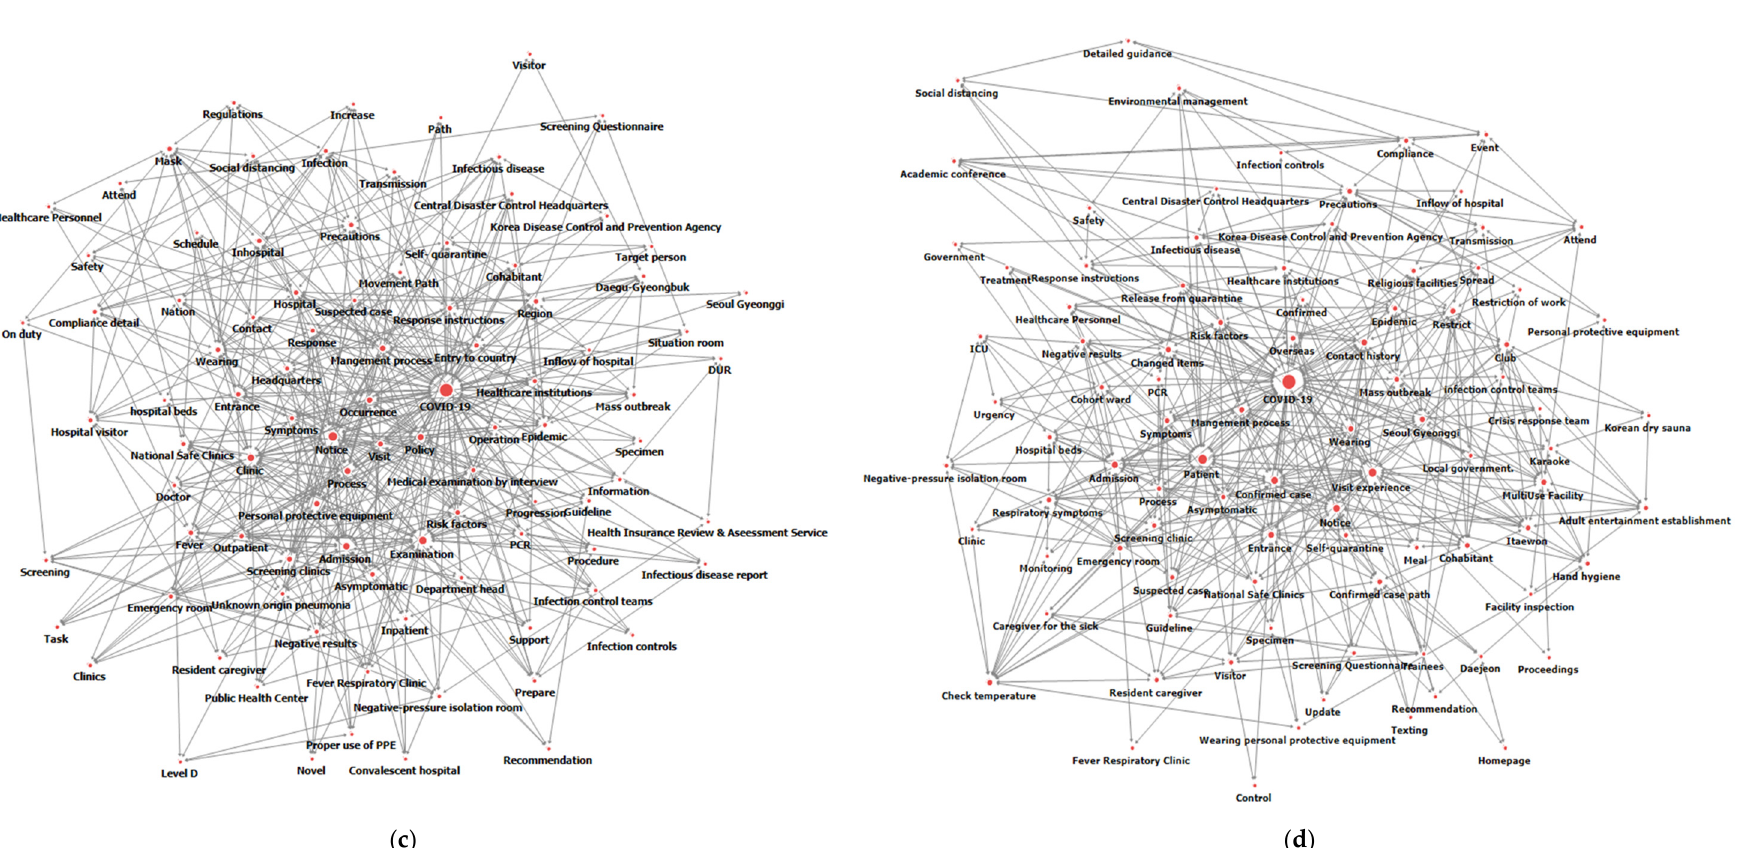
Figure 1. Keyword network of four-step crisis response : ( a ) Stage 1, ( b ) Stage 2, ( c ) Stage 3, ( d ) Stage 4.